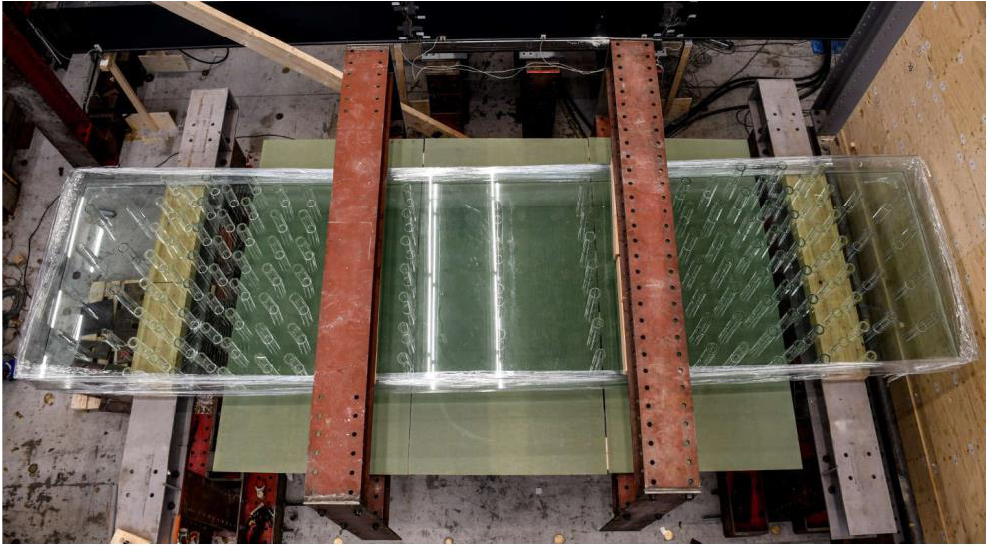
Fig. 17 Test setup from above, also showing the transparency of the glass sandwich panel.